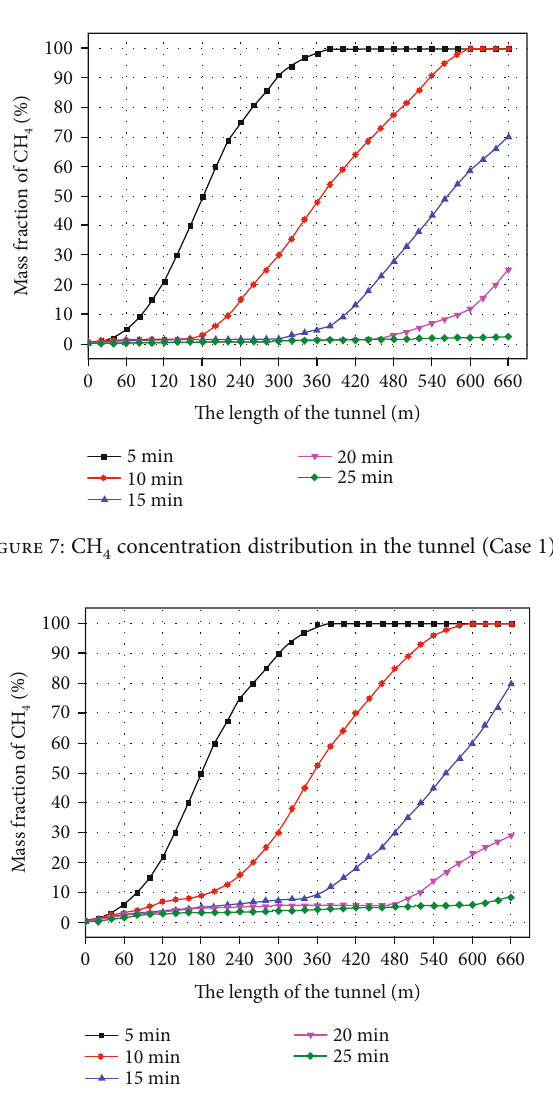
(m)0 The length of the tunnel Figure 8: CH concentration distribution in the tunnel (Case 2). 4